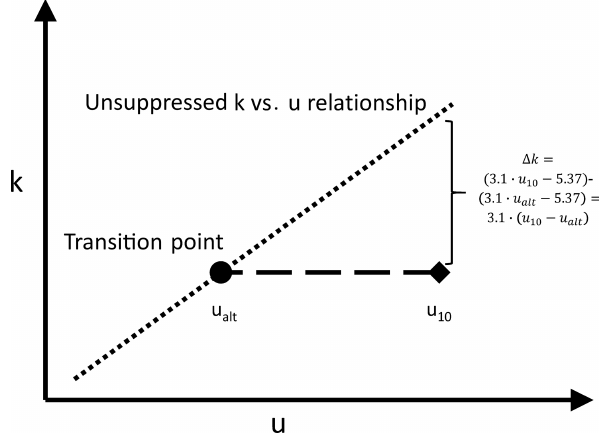
Figure B1. Illustration of the gas transfer suppression adjustments either along the wind speed or gas transfer velocity